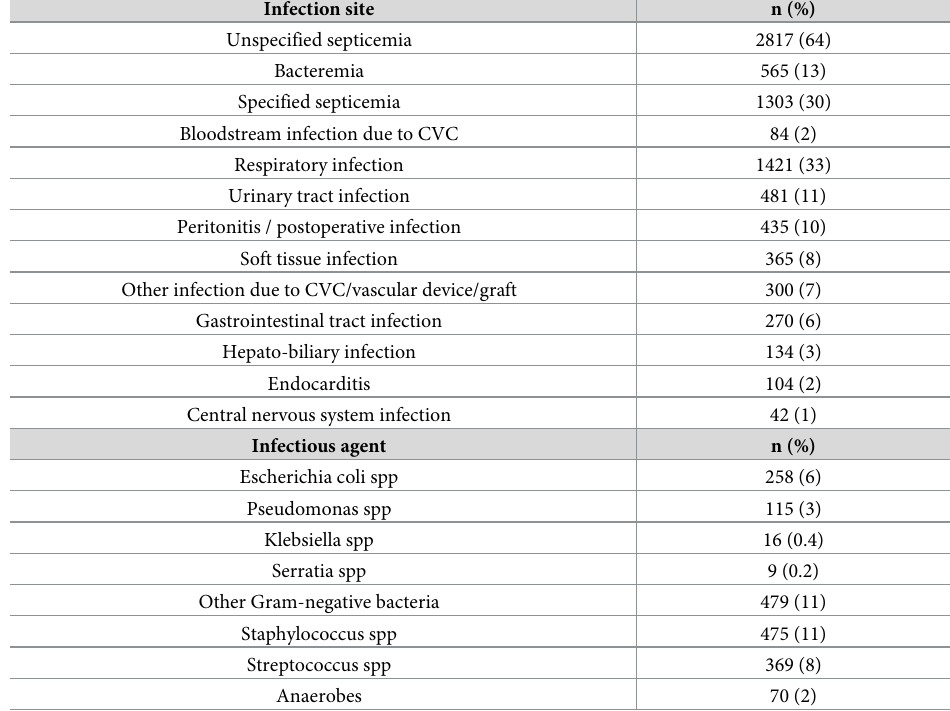
Table 5. Infection sites and infectious agents for the 4368 patients who developed sepsis within 1 year of cancer